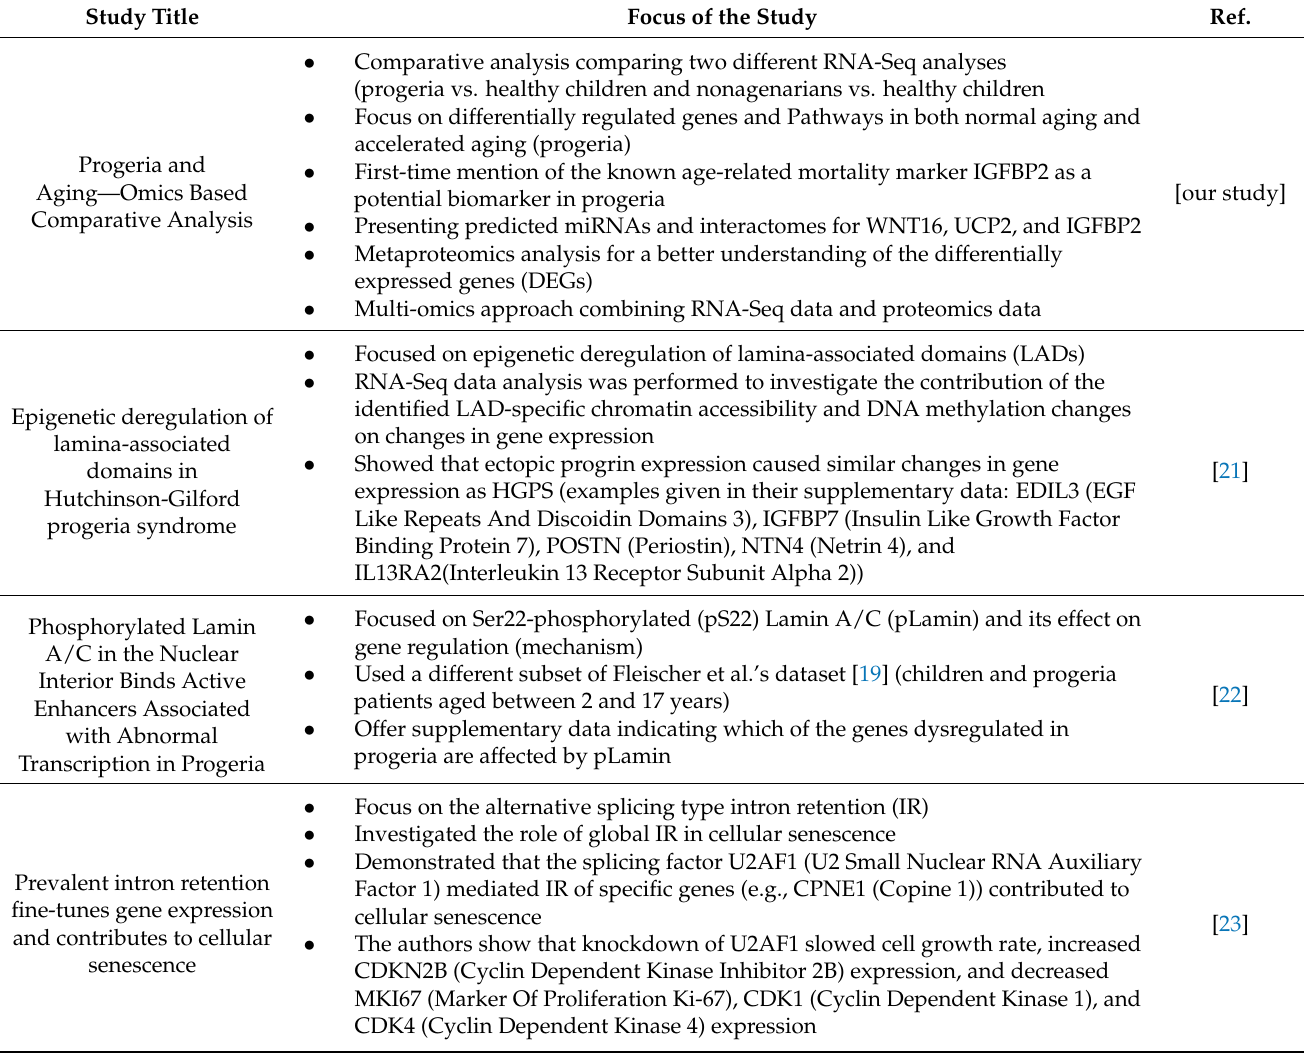
Table 1. Comparison of the previous studies mentioning the use of the GSE113957 dataset [19] with the current